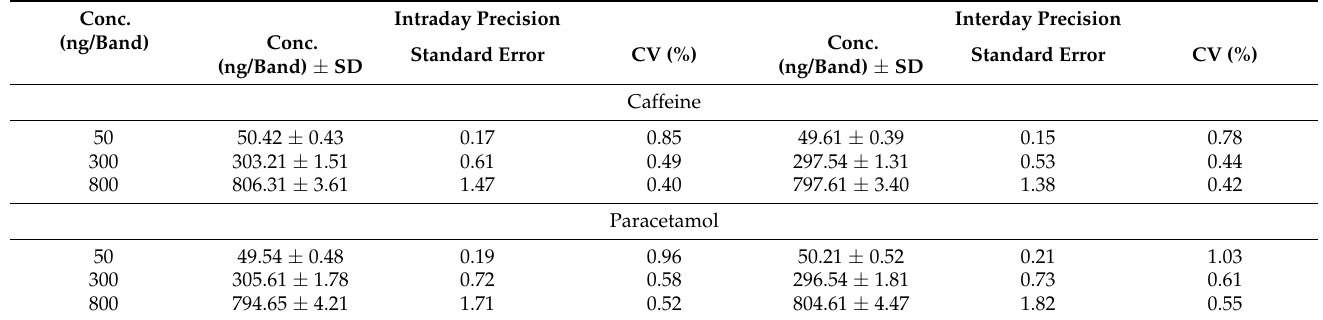
Table 8. Assessment of intra/inter-day precision of caffeine and paracetamol for the greener reversed- phase HPTLC method (mean ± SD; n =